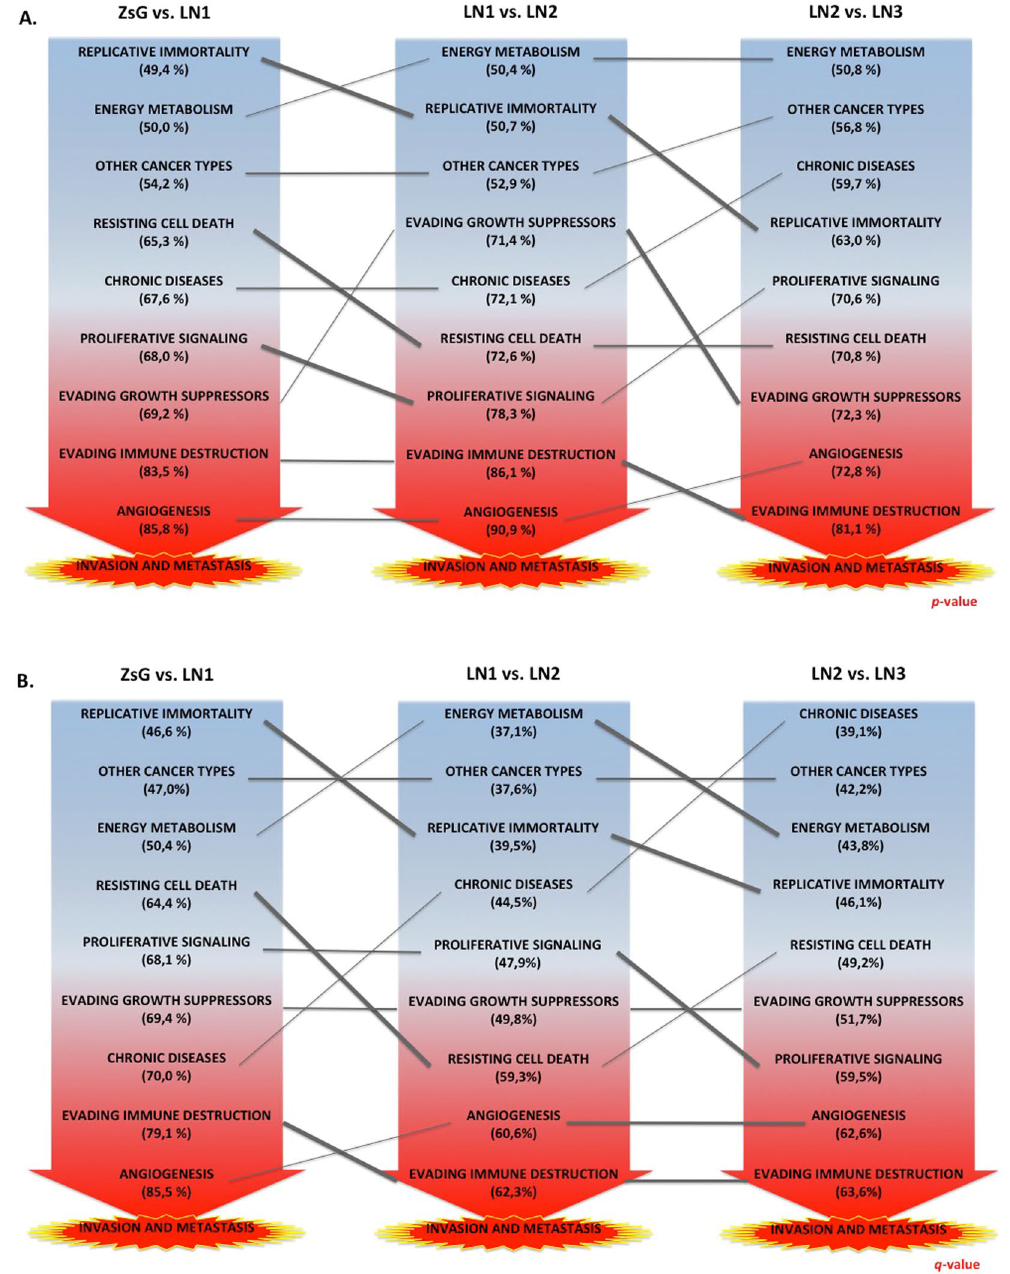
Figure 3. Individual contributions and percentages, (in parenthesis), of each hallmark to the invasive process. The total percentages are the mean of the 11-percentages of the clusters of gene expression (CoGE) for each hallmark, for ( A ) p- values, and ( B ) q-